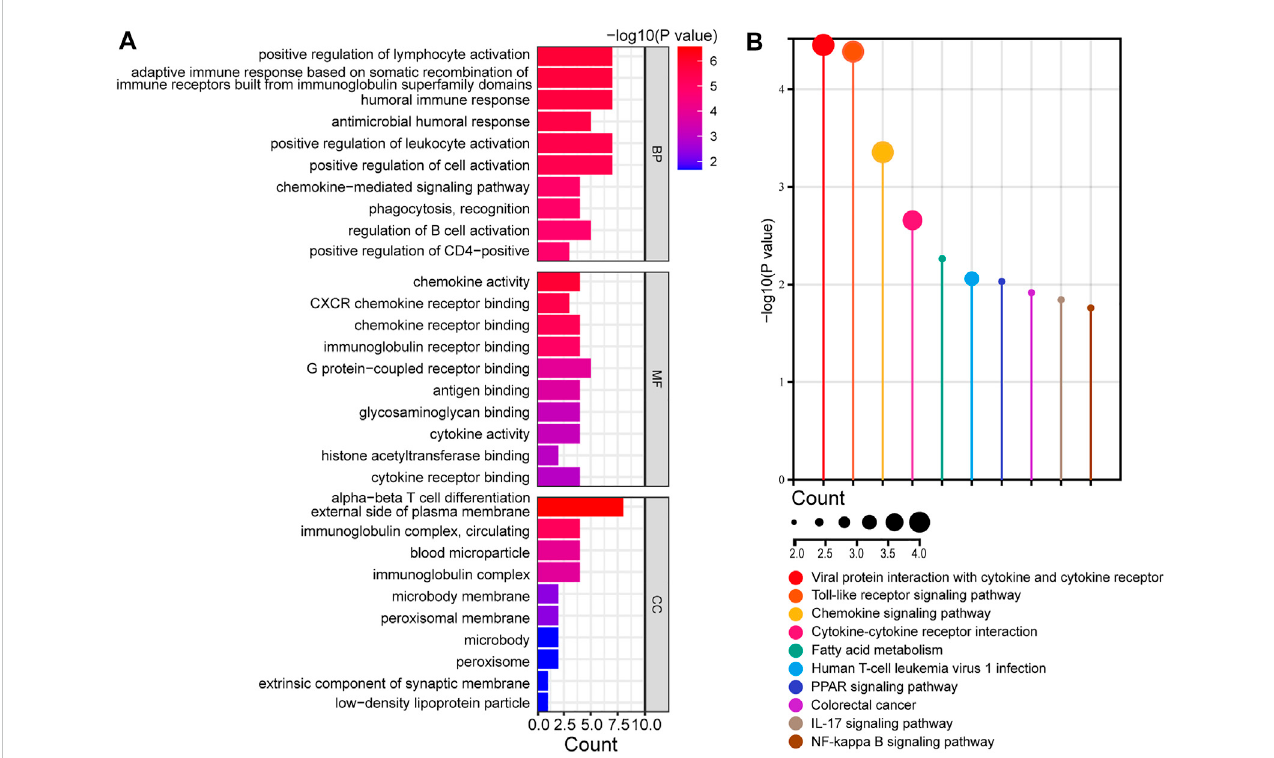
FIGURE 3 Functional enrichment analysis of DEGs. (A) Analysis of GO terms, including BPs, MFs, and CCs, of DEGs. (B) KEGG analysis of DEGs. GO, gene ontology; DEGs, differentially expressed genes; BP, biological process; MF, molecular function; CC, cellular components; KEGG, Kyoto encyclopedia of genes and